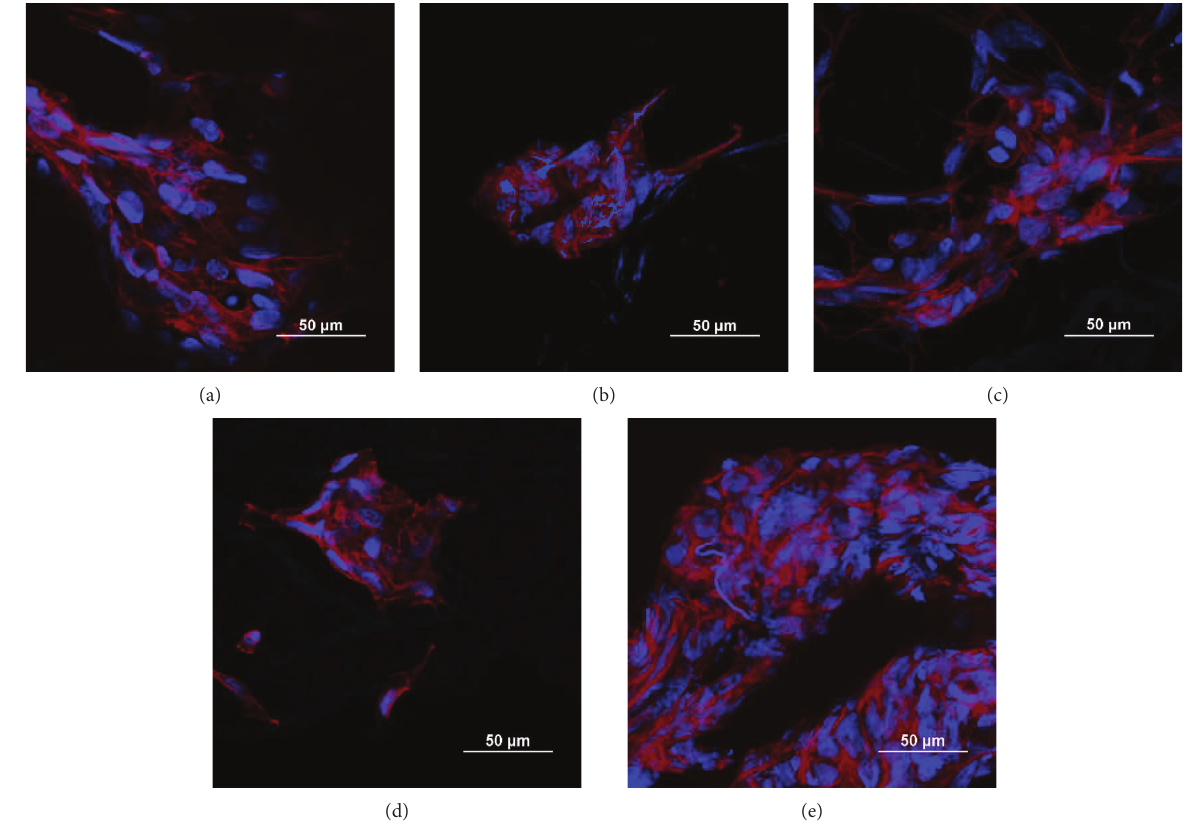
Figure 4: Cytoskeleton (red) of the hFOB 1.19 (blue nuclei) at 7 days of culture in each CA electrospun mat. (a) CA fiber mat, (b) CA-KRSR, (c) CA-RGD, (d) CA-BMP-2, and (e) CA-MP. Scale bar represents 50 µ